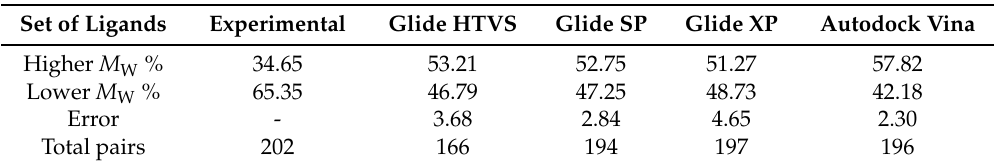
Table 3. Predictions of higher and lower M W ligand